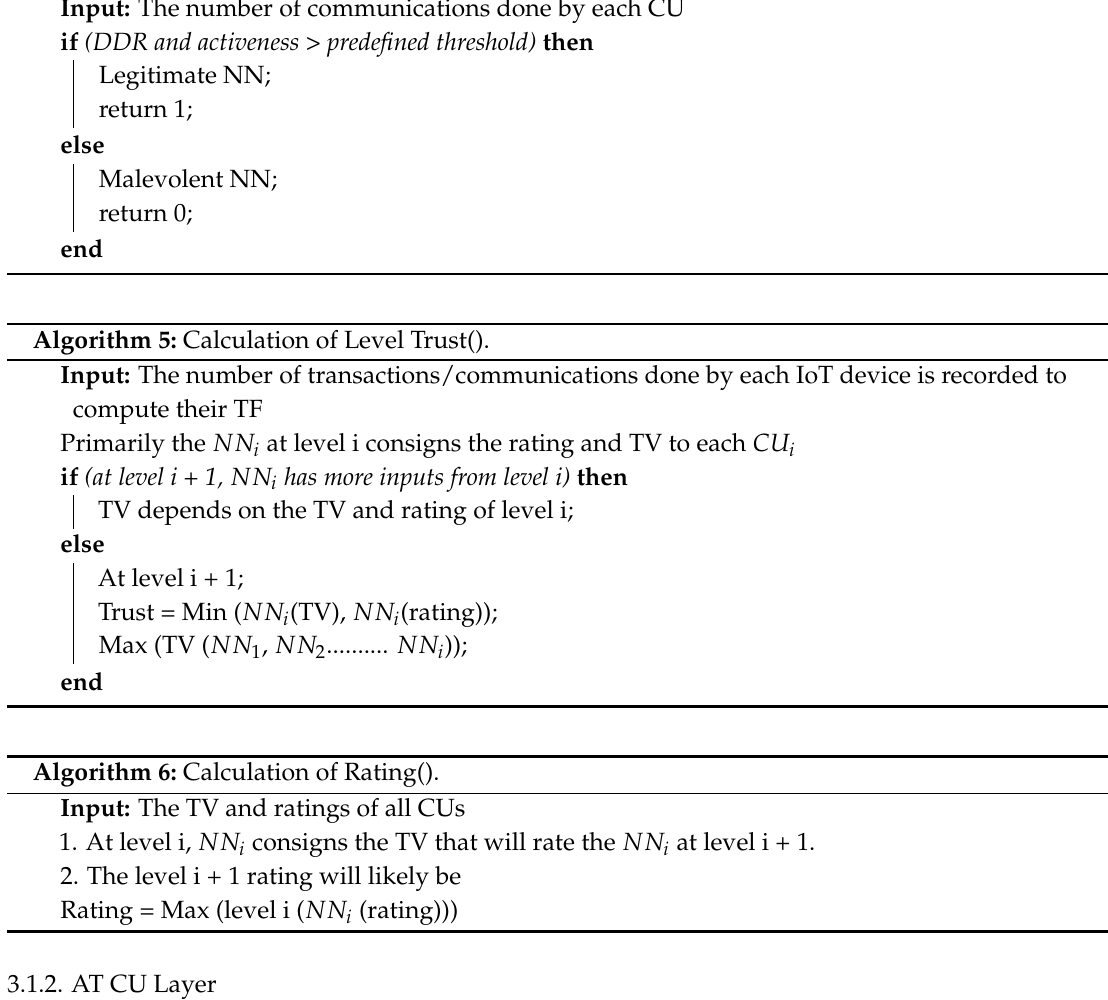
Algorithm 4: Calculation of TF().